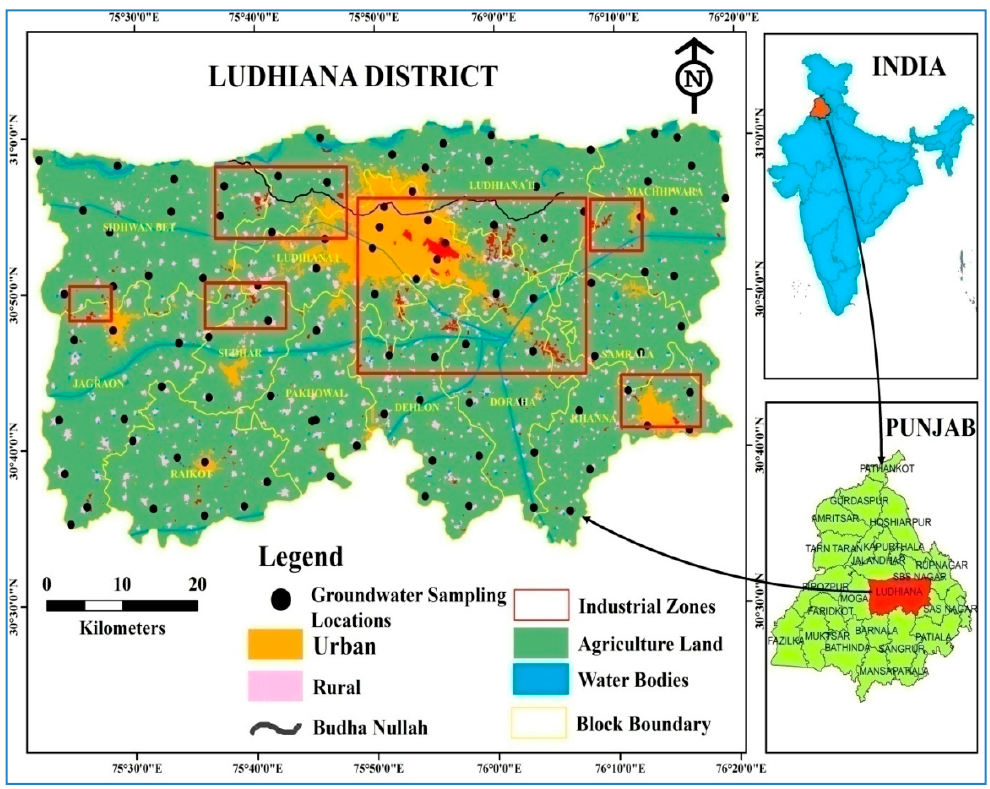
Figure 1. The study area.